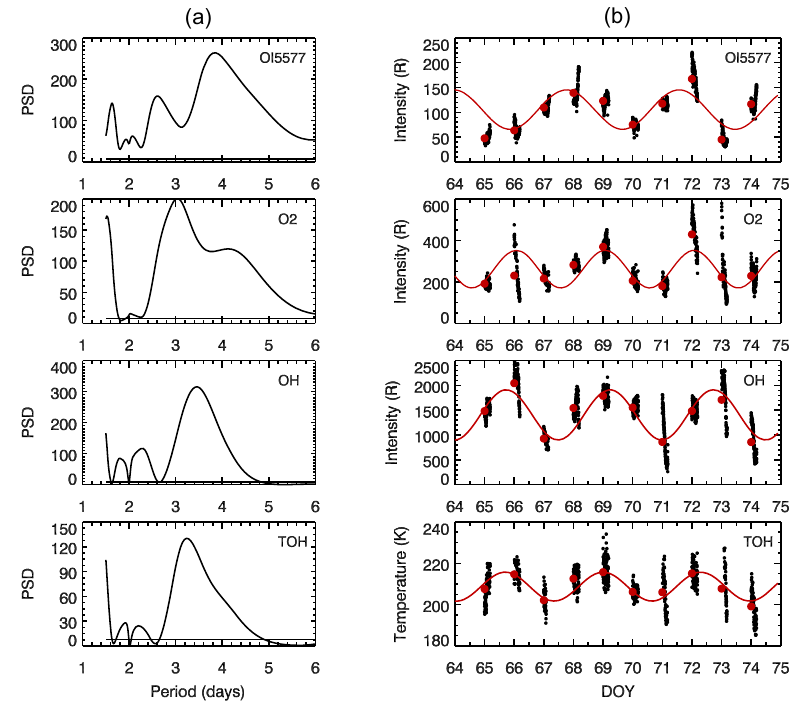
Figure 6. Lomb–Scargle (LS) spectra (a) of the OI557.7nm, O2(0-1) and OH(6-2) emissions as well as OH rotational temperature (TOH) calculated with data acquired between 00:00 and 05:00LT, along with its respective time variability from 5 to 14 March 2005 (b) . The red curve represents a harmonic fitting corresponding to each peak identified in the LS